Question: Write a descriptive caption for this figure.
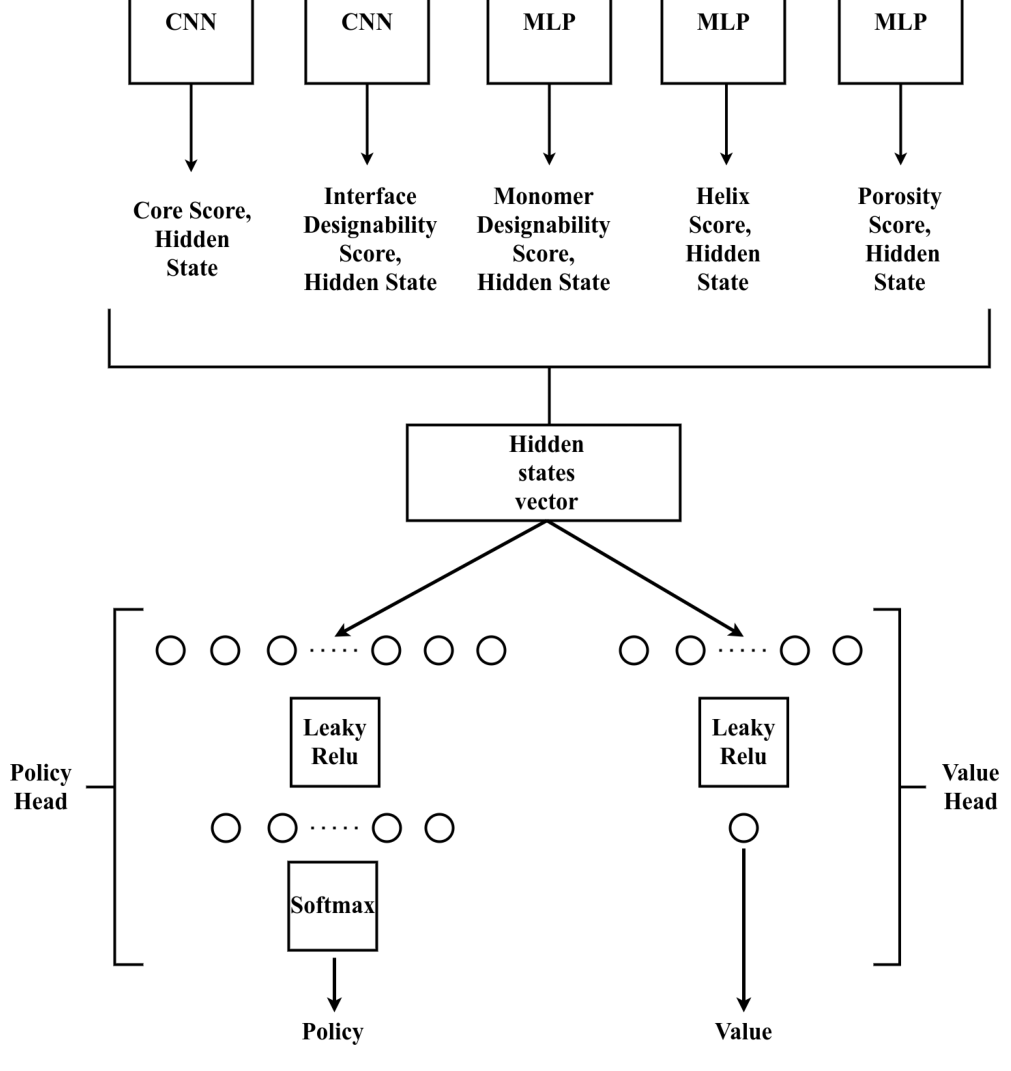
Answer: Mixture of experts architecture for AlphaZero. Circles represent linear layers. CNNs are used to predict the core and interface designability score and MLPs for the other scores. The hidden states used to compute the scores are concatenated and used by two different heads : a policy and a value head. The neural network output the policy, the value and the five different protein structure scores.